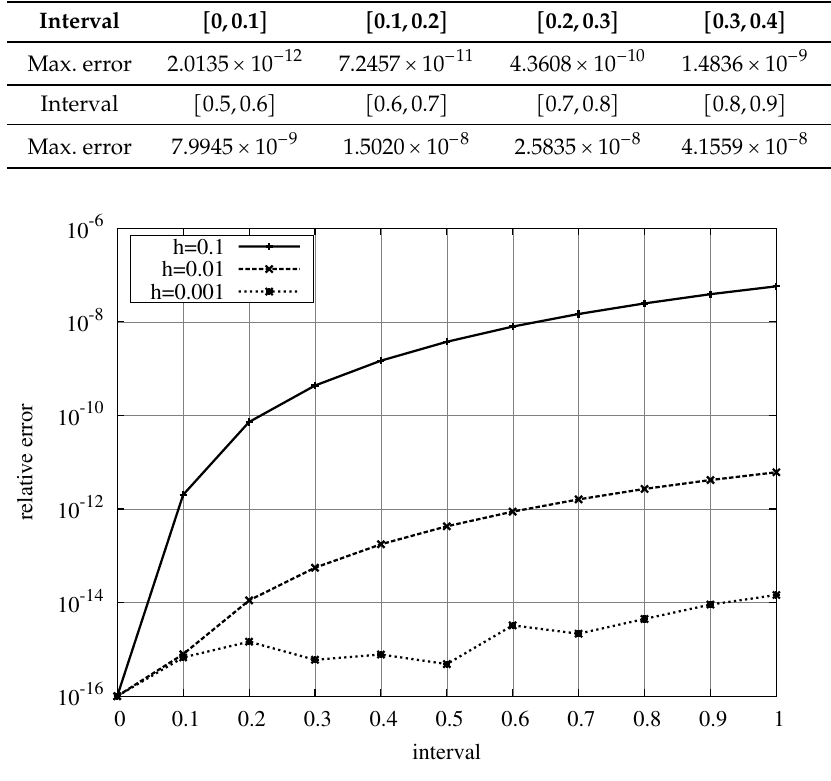
Figure 6. Relative errors for the matrix problem given in Equation (36), with seventh-order splines ( m 7) and various stepsizes ( h =